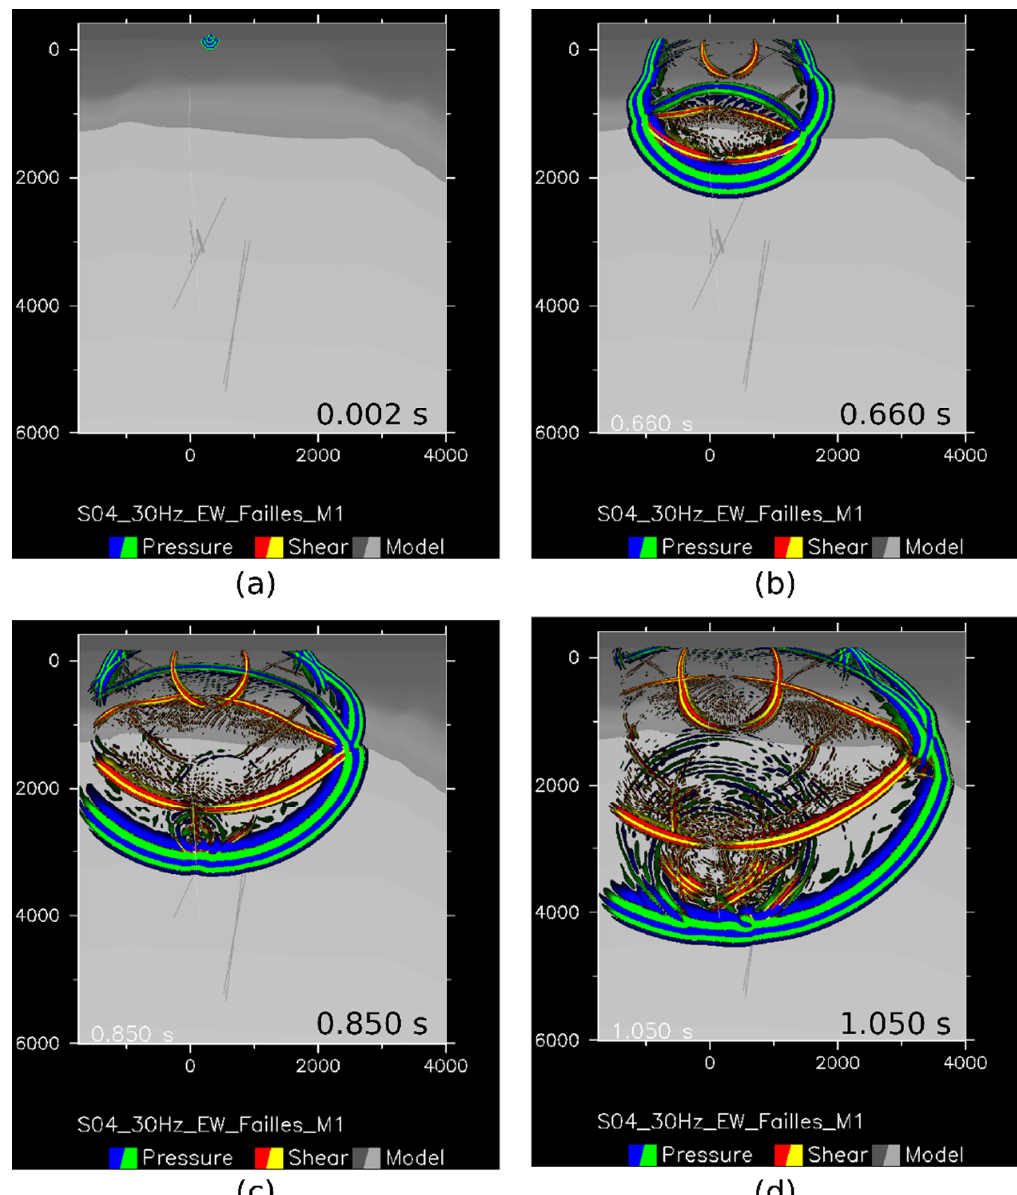
Figure 16. Representative snapshots for the multi-faults experiment at different times; ( a ) 2 ms, ( b ) 660 ms, ( c ) 850 ms and ( d ) 1050 ms. The divergence of displacements (P-waves) are shown in bleu (negative) and green (positive), and the curl of displacements (S-waves) are shown in red (negative) and yellow (positive). Notice the S-wave generated from the faults (i.e., panels c and d), the reflected and the converted waves from the top basement (e.g., panel b) and the multiples in the sedimentary layers (panel c and d), and several other waves.